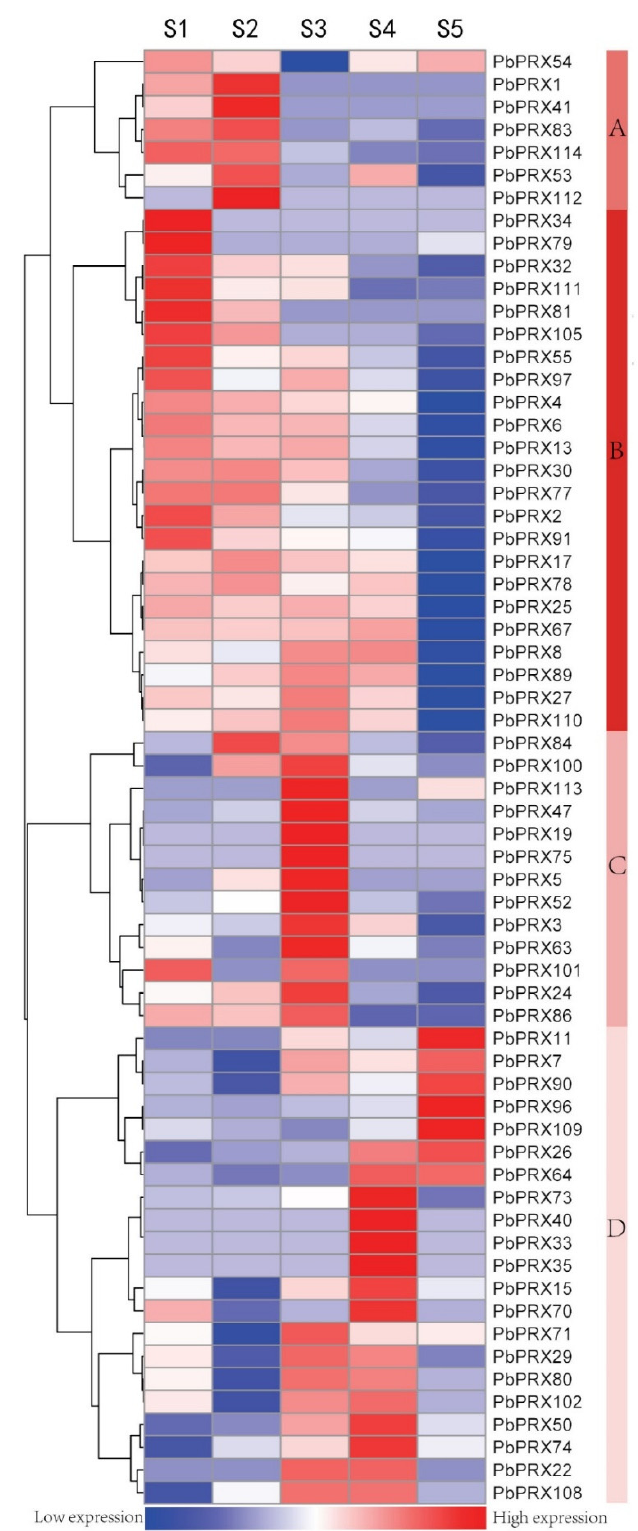
Figure 4. Heat map representation of PbPRX genes the five stages of pear fruit development. S1 22 Apr, 15 days after full bloom (DAFB); S2 13 May, 36DAFB; S3 27 June, 81DAFB; S4 28 July 110DAFB; S5 30 Aug, 145DAFB. A B C D on the right means different branches.